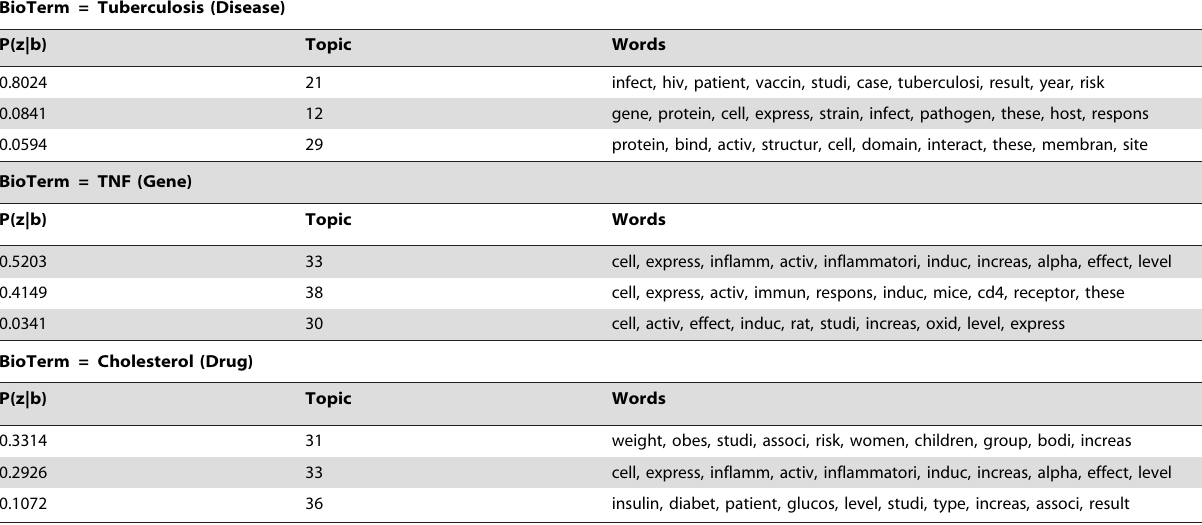
BioTerm = Tuberculosis (Disease)